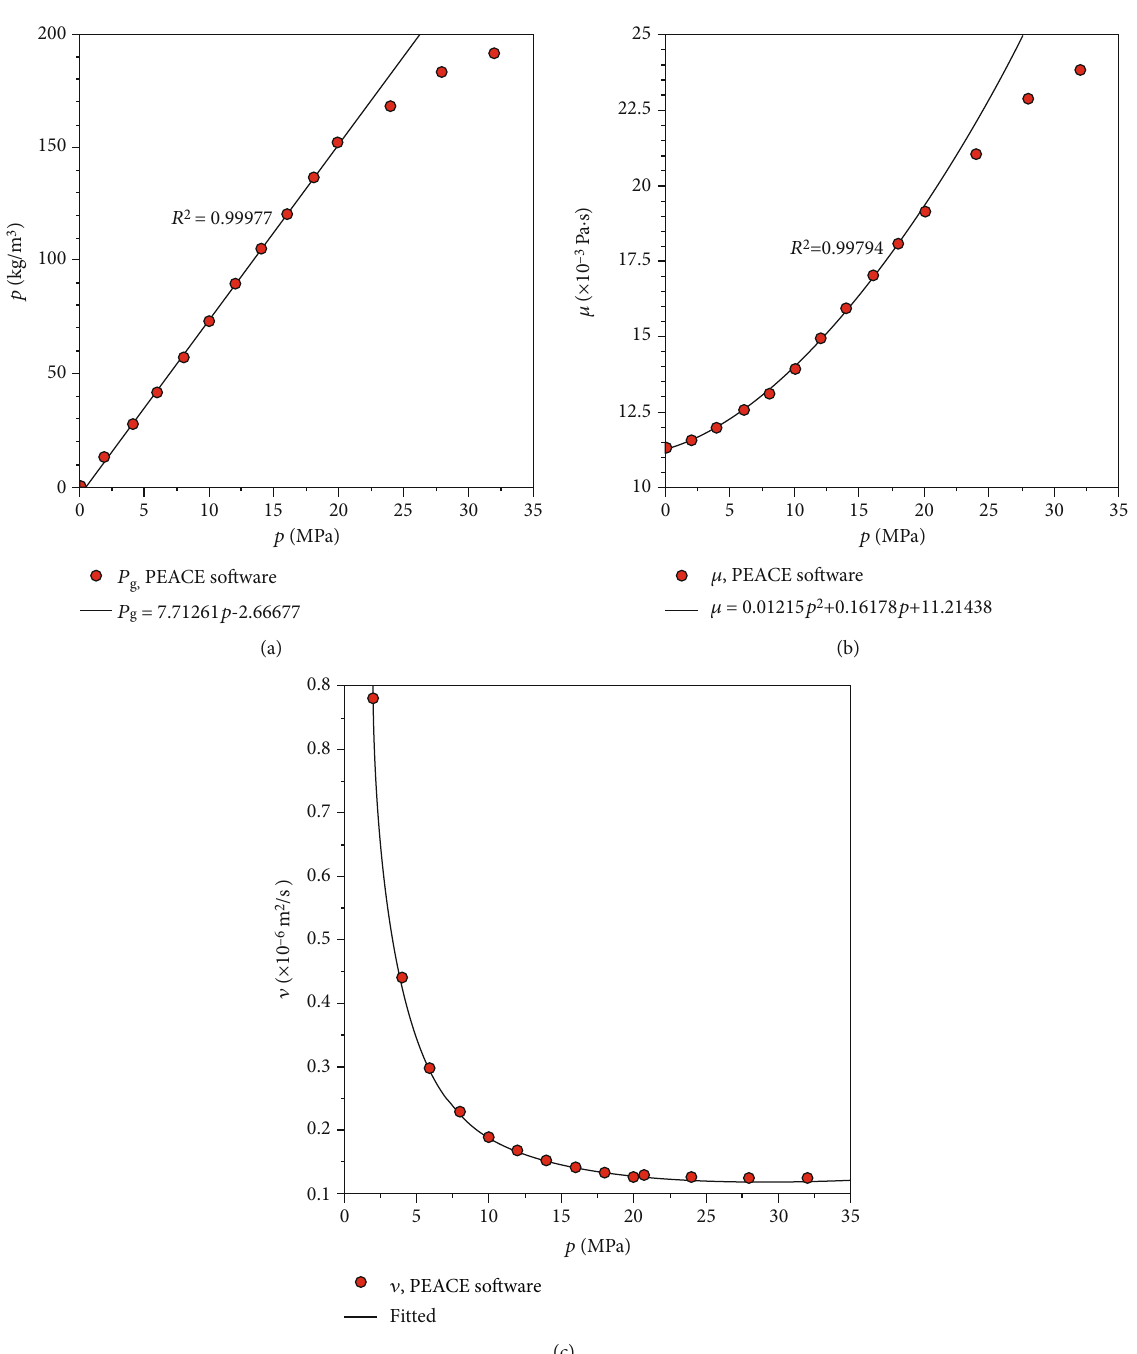
Figure 5: Methane density, viscosity coe ffi cient, and the corresponding fi tting function under di ff erent pressure conditions ((a) density, (b) dynamic viscosity, and (c) kinematic